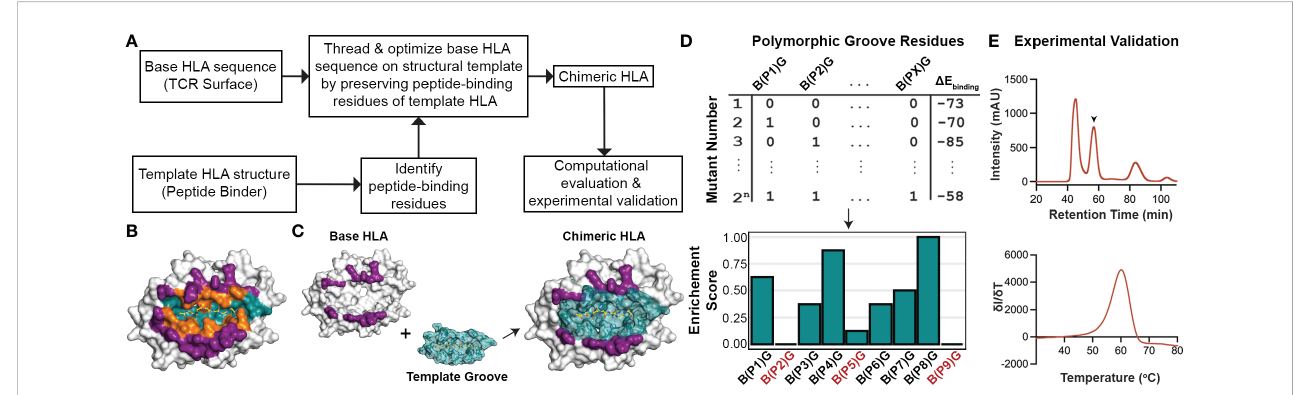
FIGURE 2 General work fl ow for generating chimeric HLA molecules using a fi xed-backbone, structure-guided approach. (A) The general work fl ow of the CHaMeleon approach to generate chimeric MHC-I molecules. (B) The structure of HLA-A*02:01 bound to the peptide SLLMWITQC (PDB ID:1S9W) where the peptide-only (teal), TCR-only (purple) and peptide-TCR-binding (orange) residues are highlighted. (C) Grafting the peptide-biding groove of a template onto a base allele to create chimeric molecules. TCR-only positions are highlighted in purple and peptide-only or peptide-TCR-binding residues are highlighted in teal. The structure of HLA-A*02:01 (PDB ID:1S9W) was used as an example. (D) Exhaustive combinatorial sampling of groove allele substitutions on the base allele and binding energy calculations was performed to evaluate the chimeric HLA models. The top 2.5% of structures with lowest binding energies were used to calculate Enrichment Scores at each polymorphic position (PX) in the groove, which represents the fraction of chimeric HLAs with a speci fi c mutation from base (B) to groove (G) allele residue. Positions with 0 or very low enrichment scores are highlighted in red. (E) Experimental validation of the chimeric pMHC-I by size exclusion chromatography (SEC; top). The protein peak is indicated by the arrow (57.5 min), while the additional peaks correspond to protein aggregates (47 min) and free b 2 m (84 min). Thermal stability of the puri fi ed molecules was assessed using differential scanning fl uorimetry (DSF; bottom)